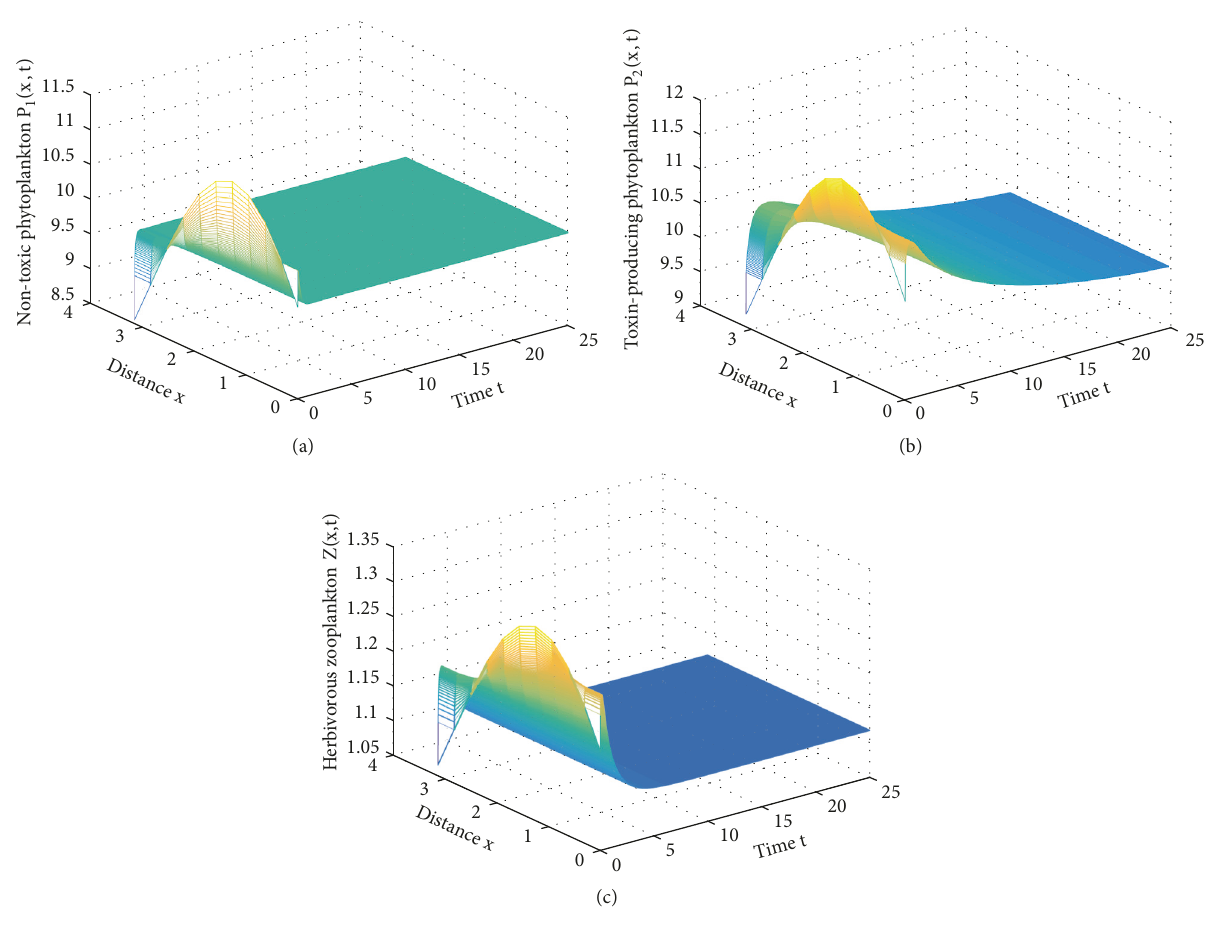
Figure 1: The equilibrium solution 𝐸 ∗ of (3) is asymptotically stable when 𝜏 = 0